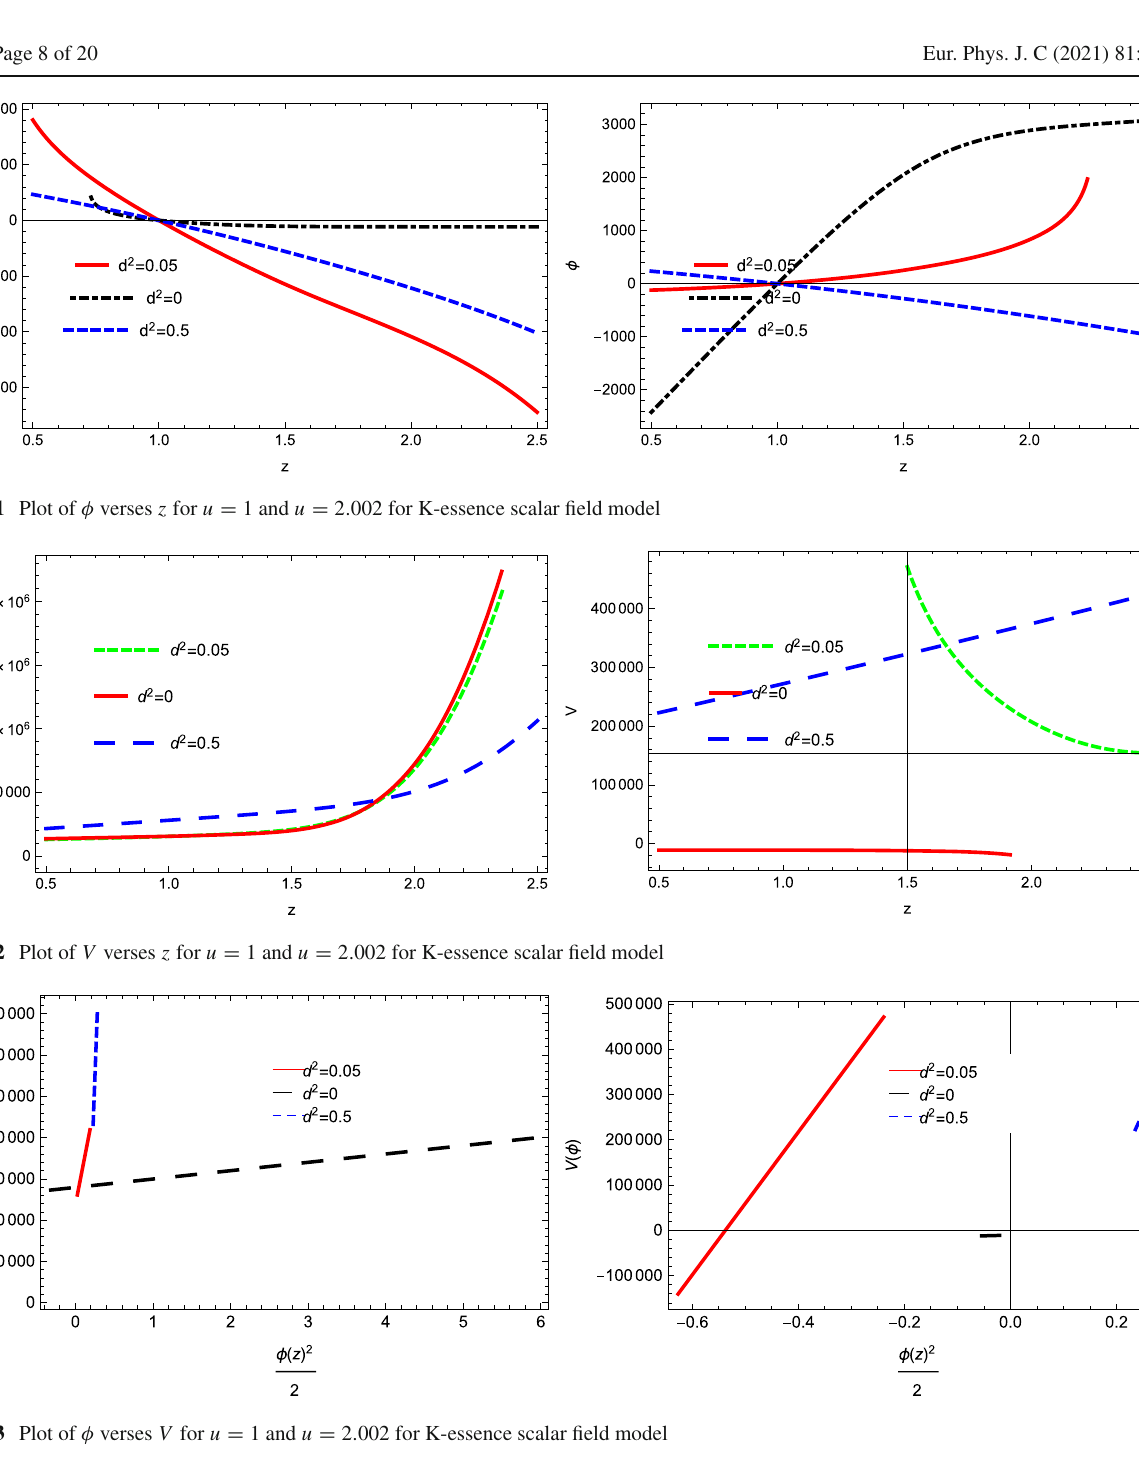
4 Reconstruction of scalar field model for